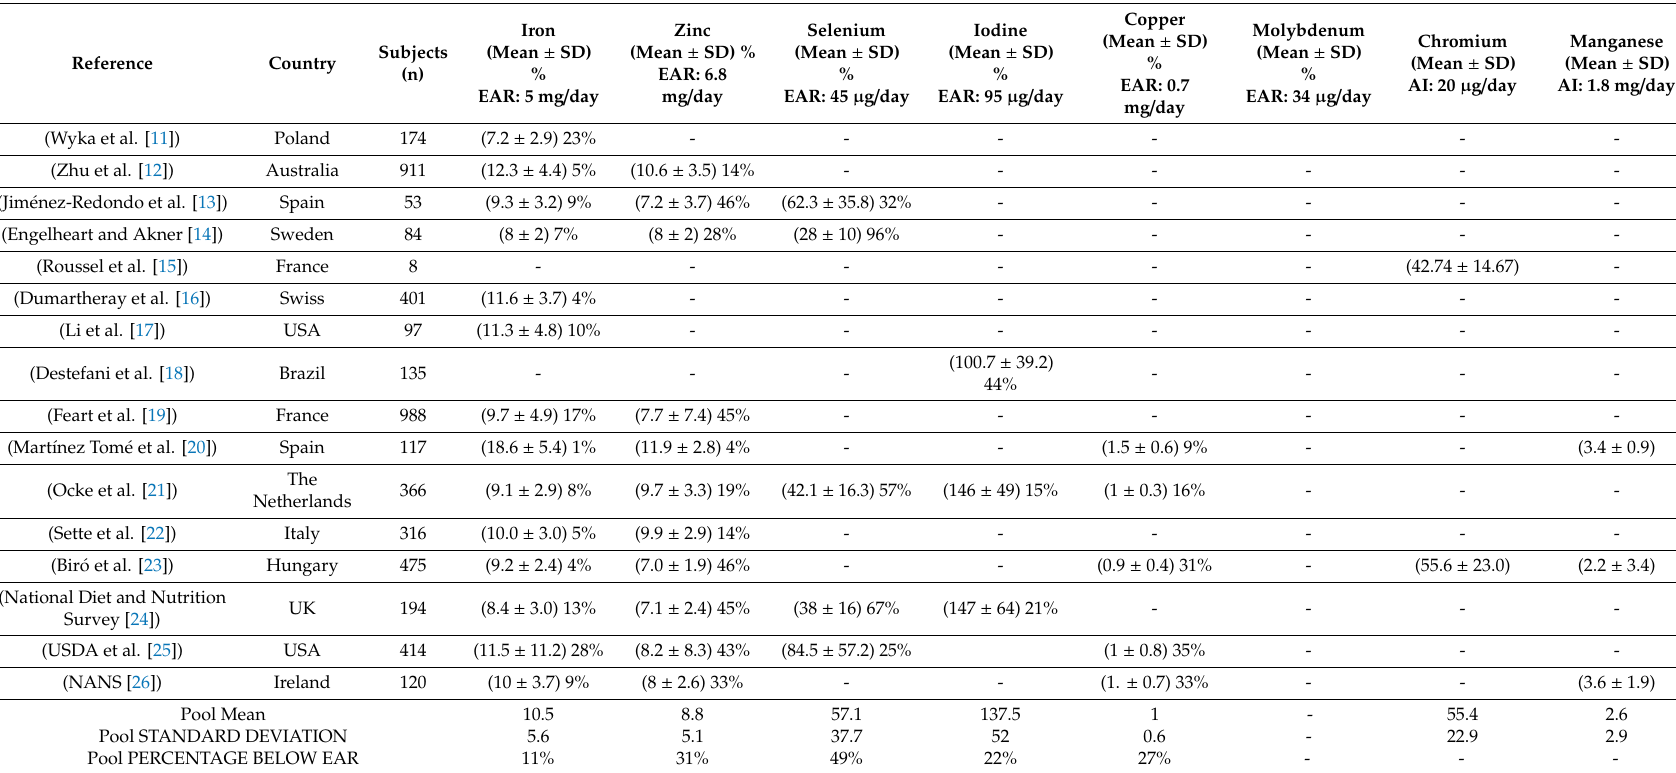
Table 4. Percentage of free-living older women with mineral intakes below the Estimated Average Requirement (EAR) or Adequate Intake (AI) and therefore at increased risk for inadequacy. Mineral intakes are presented as mean + SD. Individual study date and percentage of the free-living population at risk for inadequacy, trace mineral intakes among older